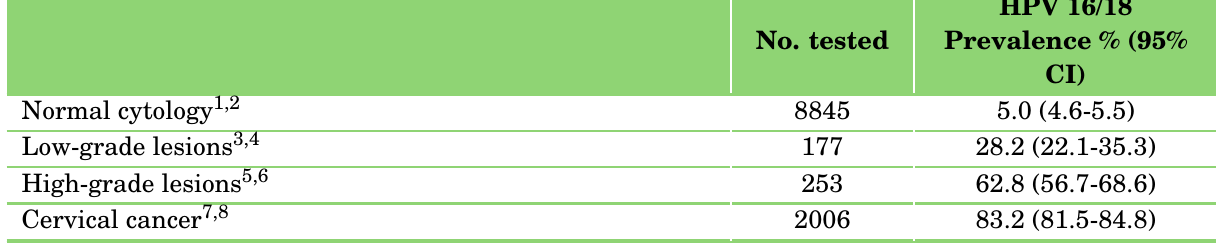
Table 21: Prevalence of HPV16 and HPV18 by cytology in India